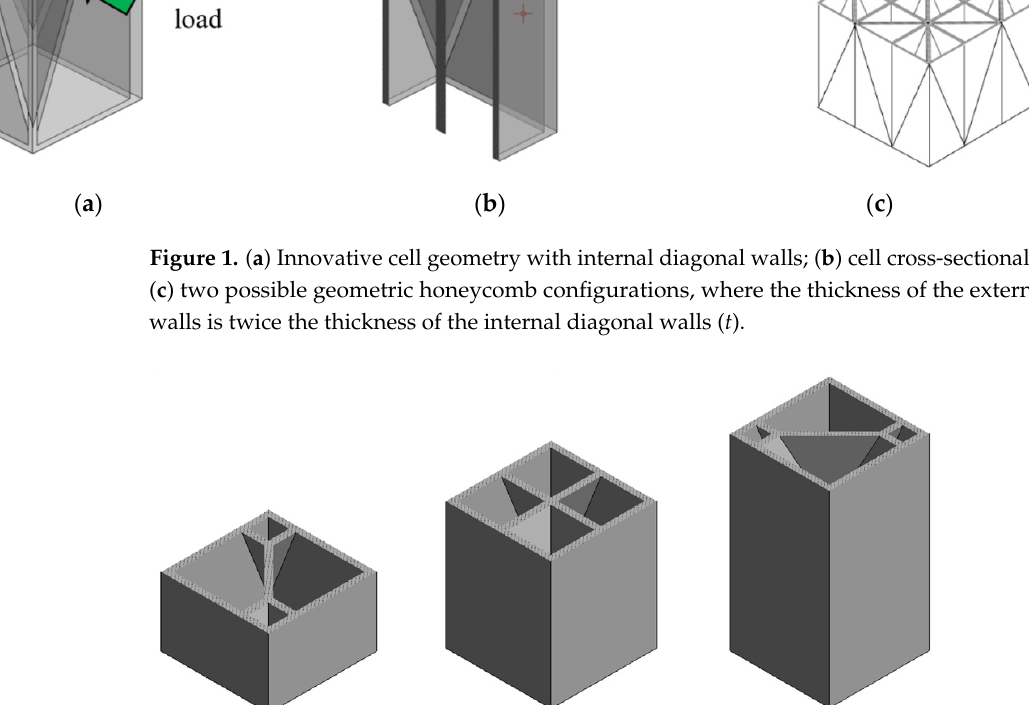
Figure 2. Innovative cell cross section at 25, 50 and 75 percent of the cell height.